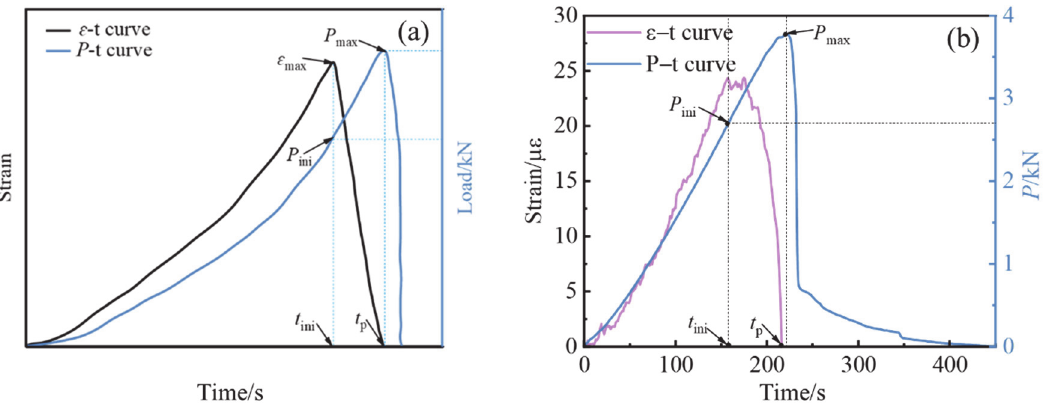
Figure 15. Variation diagram of strain and load with time: ( a ) schematic; and ( b ) experimental result.